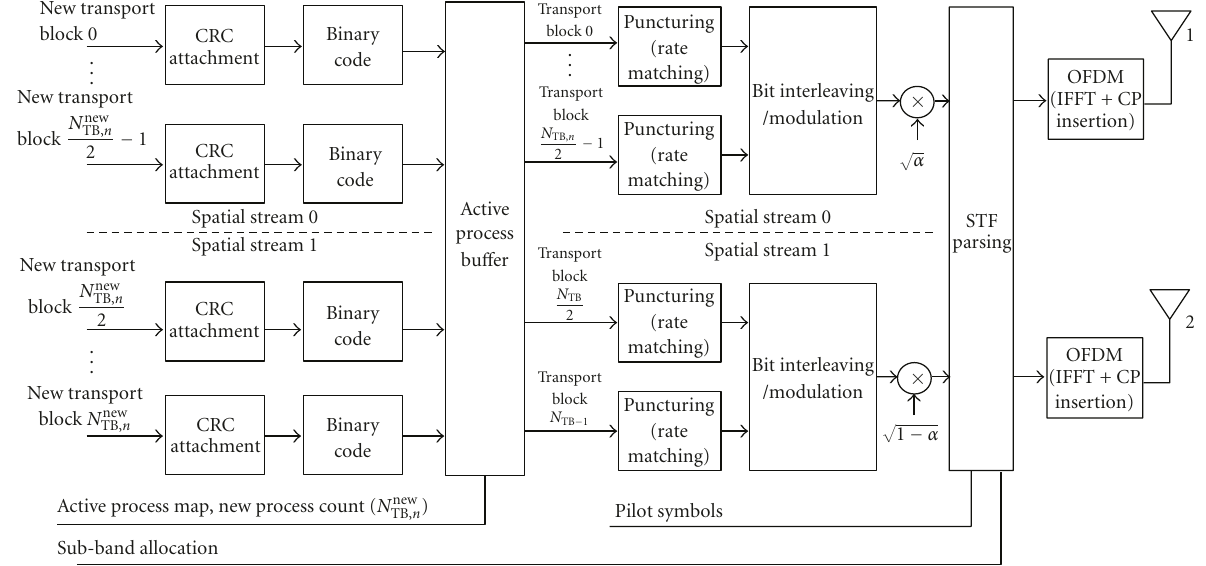
Figure 6: OpenAirMesh Coded Modulation and HARQ.